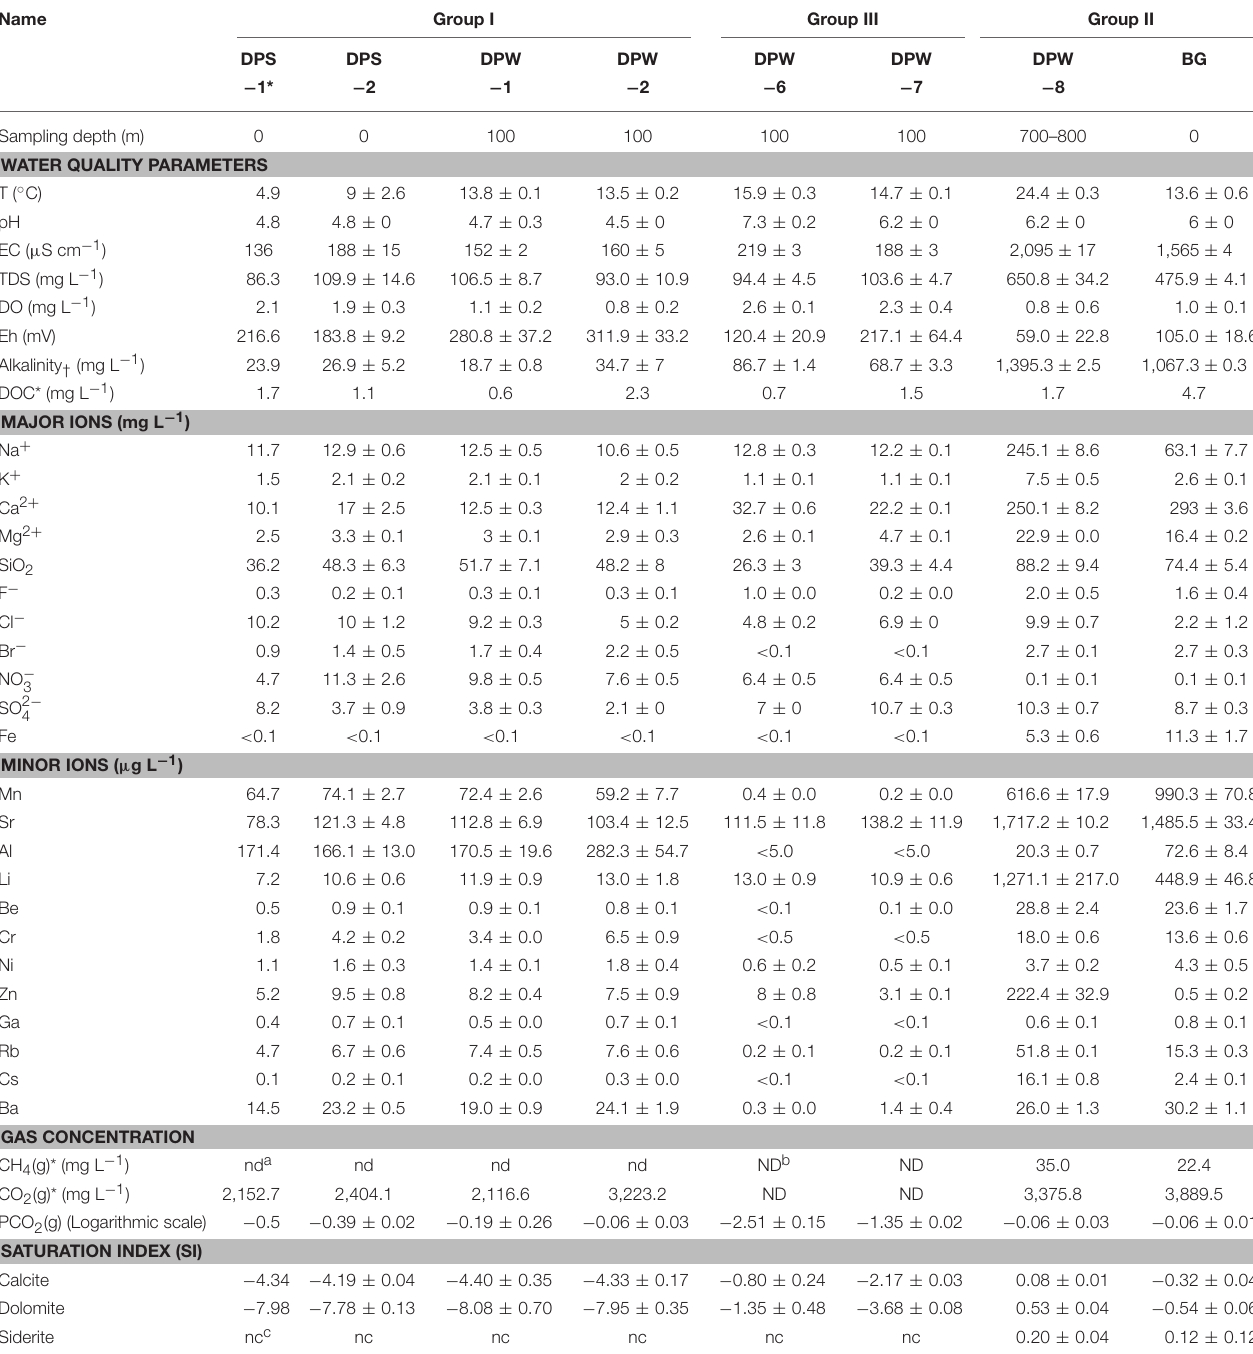
TABLE 1 | Physical and chemical characteristics of ground water